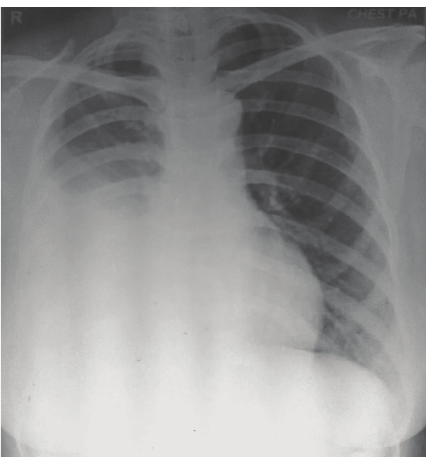
Figure 1: CXR, PA view showing right-sided pleural effusion.